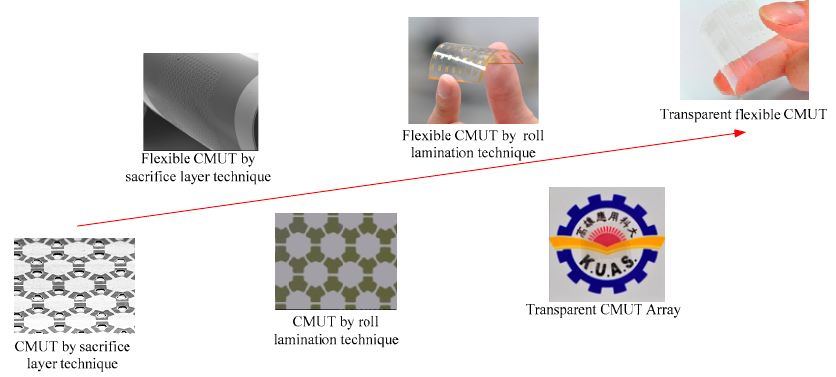
Figure 1. CMUT research results from our group.